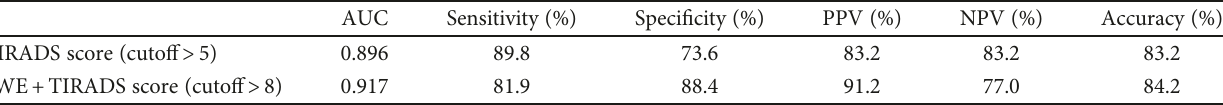
Table 8: Diagnostic performance of TIRADS and SWE +TIRADS